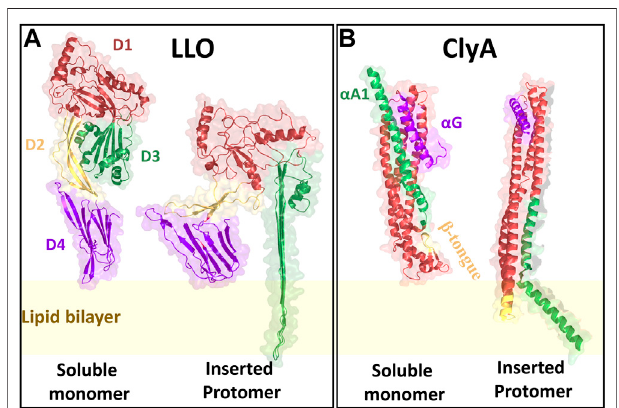
FIGURE 3 | The crystal structures of LLO and ClyA monomers in their soluble as well as inserted states. LLO is structurally designated with four domains D1 (red), D2 (yellow), D3 (green) and D4 (purple). ClyA has three major motifs that play a signi fi cant role during pore formation: β tongue (yellow), C-terminal α G motif (purple) and N-terminal α A 1 motif (green). The crystal structures are reconstructed from the PDB fi les using PyMOL. Since, the LLO inserted state crystal structure is not yet elucidated, the structure of Pneumolysin was used as to create the structure. For LLO monomer PDB id: 4CDB; Pneumolysin insertedstatePDBid: 5LY6;ClyAsolublemonomerPDB id: 1QOY; ClyA inserted state PDB id: